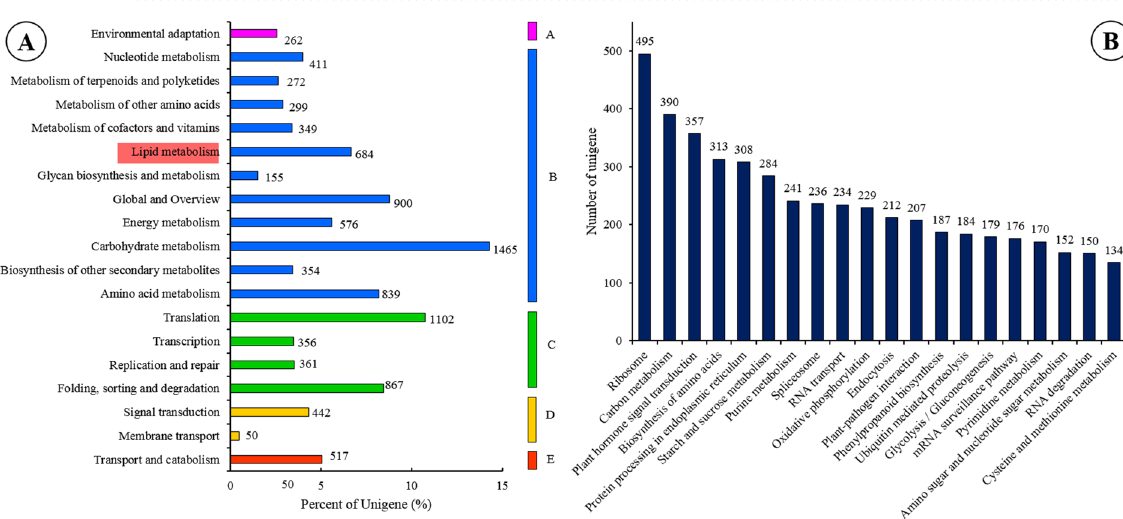
Figure 5. Kyoto Encyclopedia of Genes and Genomes (KEGG) annotation for the transcriptome sequences of sacha inchi: ( A ) as unigenes classified into five categories on the basis of the KEGG database, including A (pink colour): Organismal System; B (blue colour): Metabolism; C (green colour): Genetic Information Processing; D (yellow colour): Environmental Information Processing; E (red colour): Cellular Processes, with the x-axis indicating the percentage of unigenes in each category; and, ( B ) the 20 pathways with the highest numbers of annotated and enriched unigenes are shown along the x-axis with the y-axis indicating the number of unigenes in each